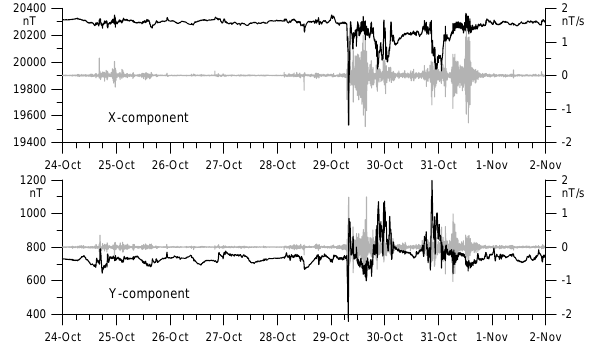
Fig. 2. North, X, and east, Y, components of the geomagnetic field recorded at the Geomagnetic Observatory Budkov between 24 Oc- tober and 1 November 2003 (black lines) and their time derivatives (shadow lines). The sampling rate is